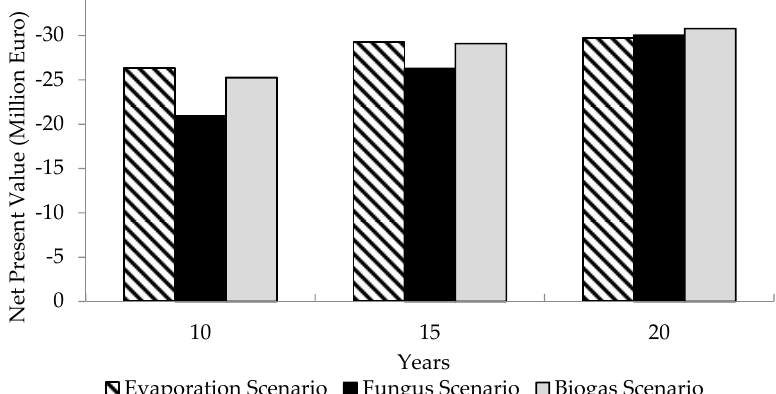
Figure 4. Net present value for the different scenarios after 10, 15 and 20 years.